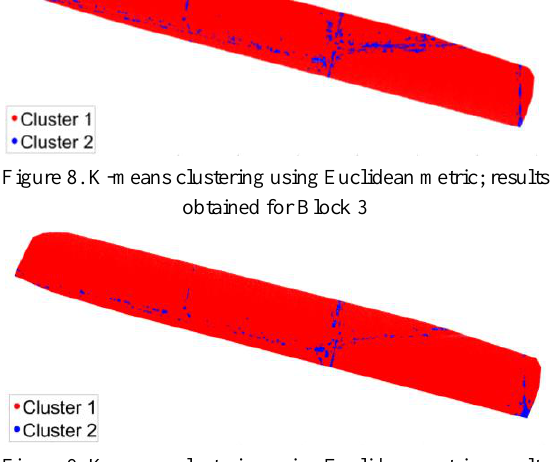
Figure 9. K-means clustering using Euclidean metric; results obtained for Block 4